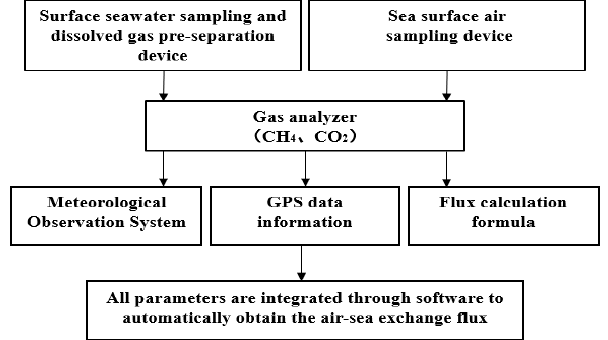
Figure 2. Technology roadmap of main research content.